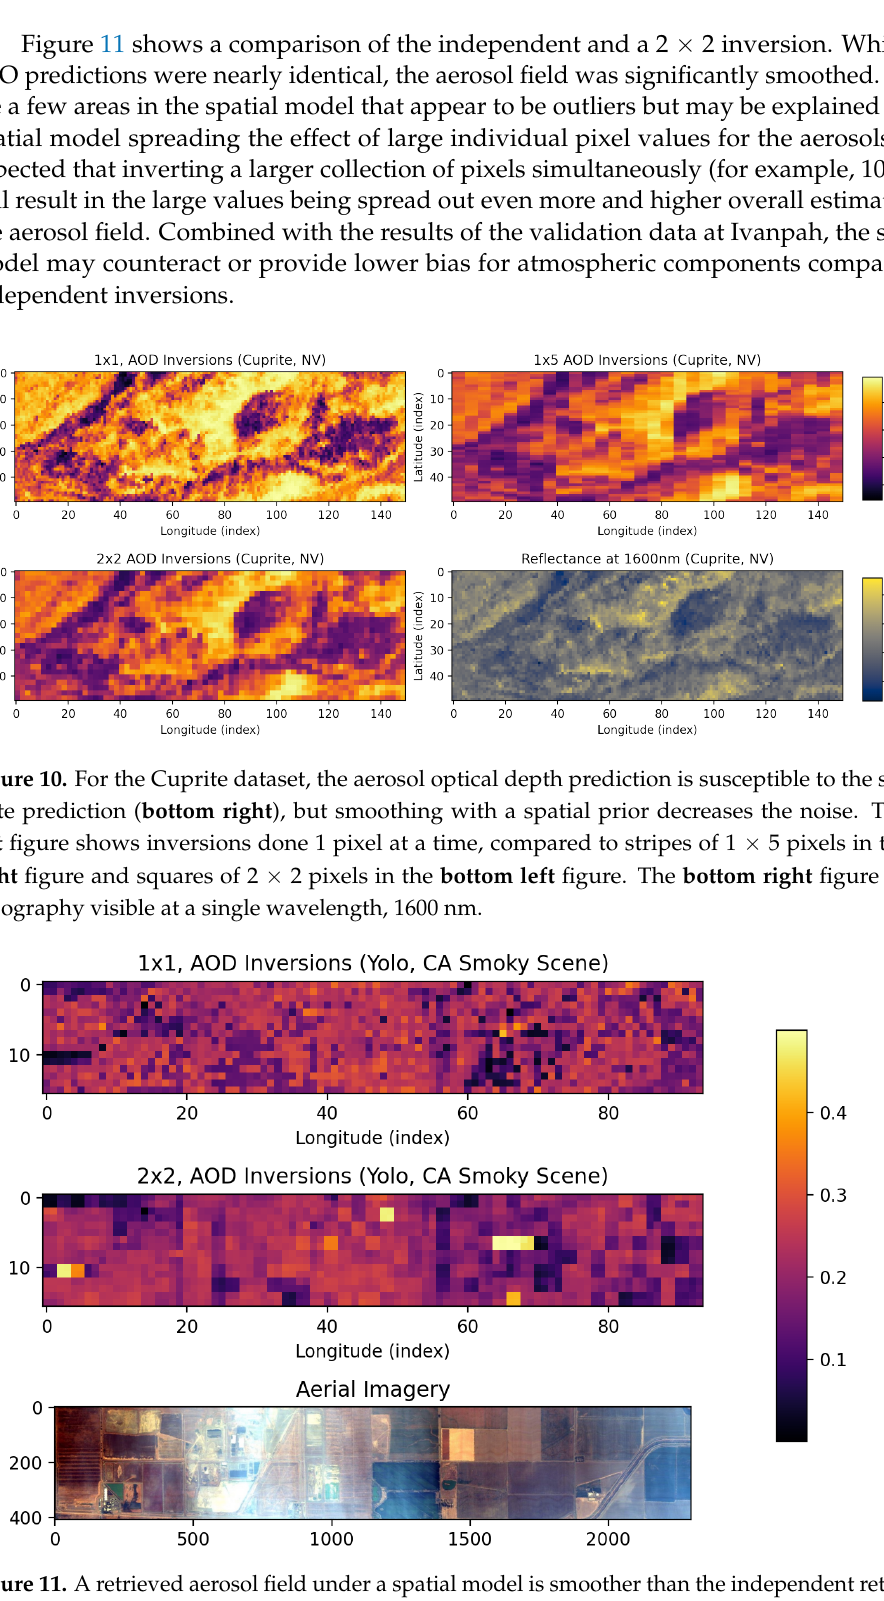
Figure 11. A retrieved aerosol field under a spatial model is smoother than the independent retrievals and spreads out large